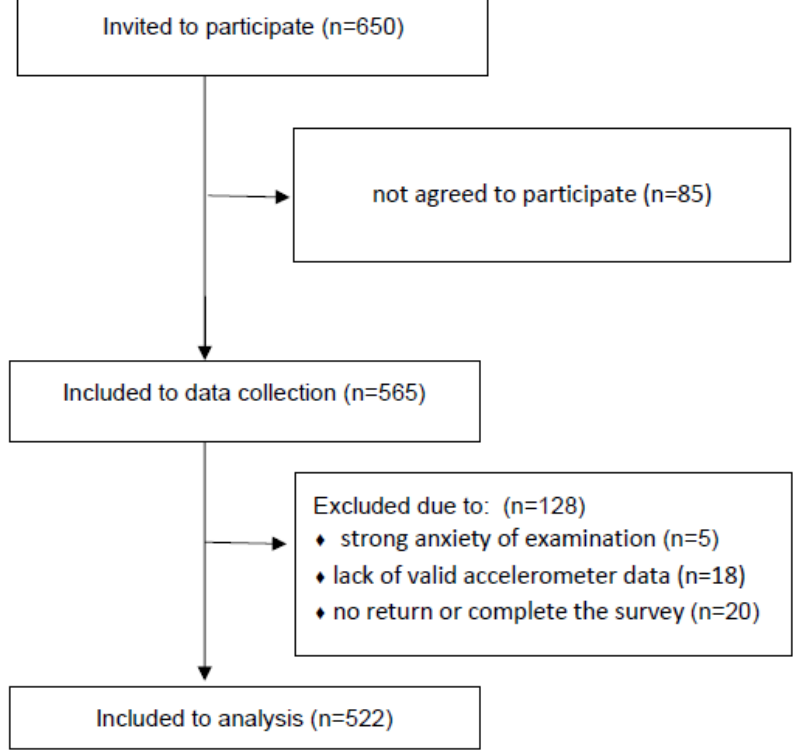
Figure 1. Flow diagram for participant recruitment.